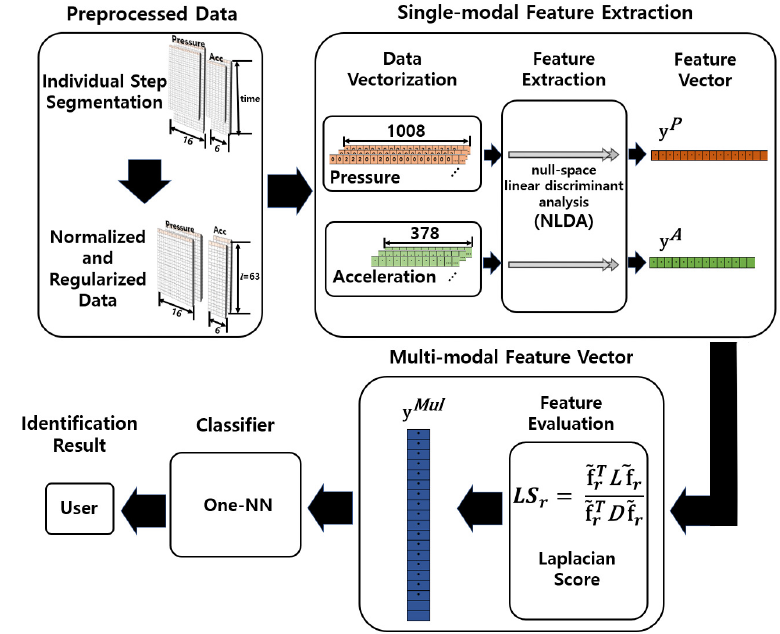
Figure 3. Procedure of the proposed method for user